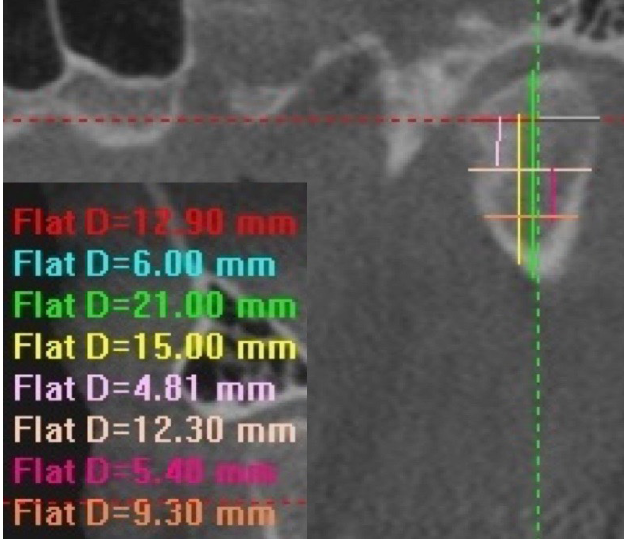
Fig.3. Coronal Superior measurements (red), Coronal Superior-inferior measurement (green), Coronal Medium measurement (salmon) and Coronal Inferior measurement (orange), carried out in the condyles on coronal reformatting. The other measures that appear (yellow, light pink, pink and light blue) were performed to determine the locations of the coronal